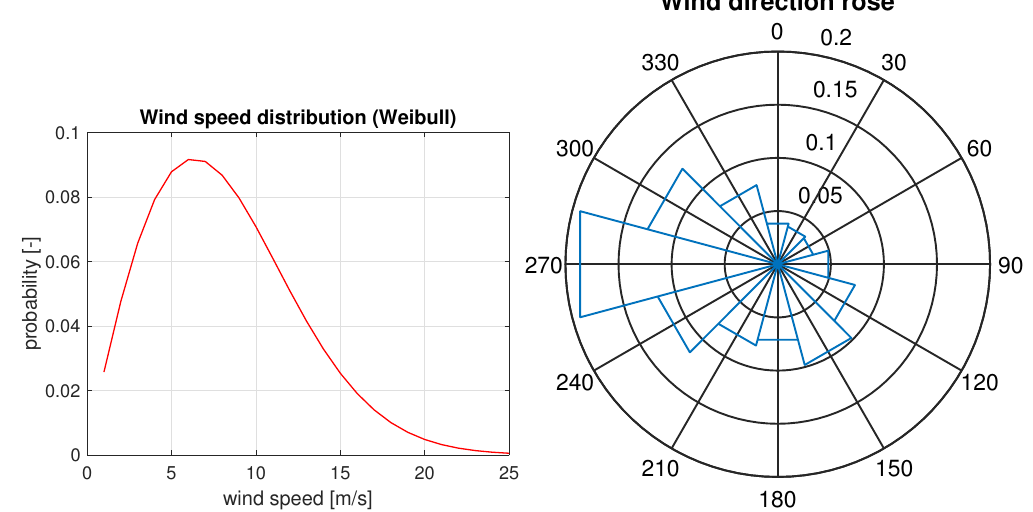
Figure 4. Wind speed ( left ) and wind direction ( right )